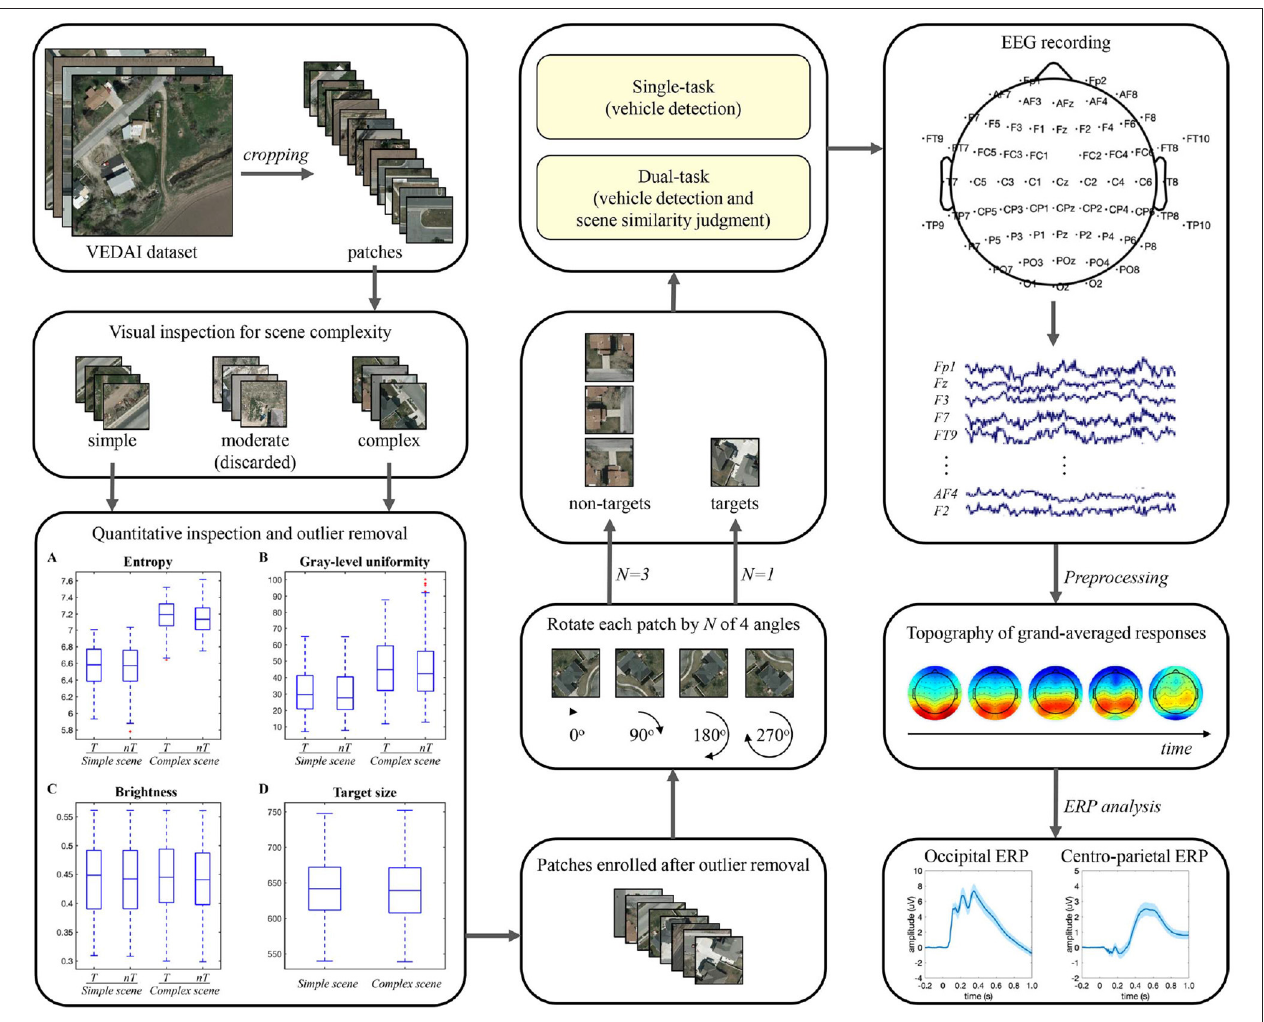
FIGURE 1 | Pipeline of stimulus set generation and EEG data analysis.